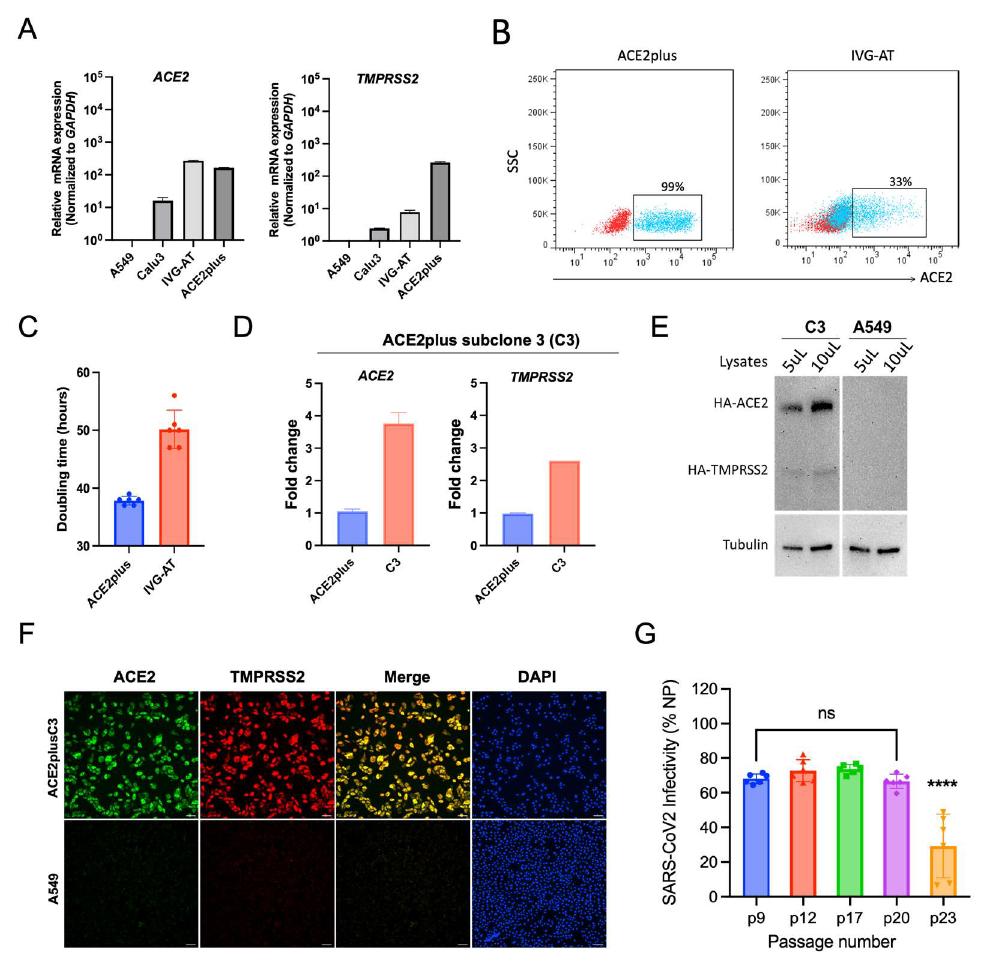
Figure 3. The characterization of the ACE2plus and ACE2plusC3 cell lines. The mRNA expression levels of ACE2 and TMPRSS2 in the indicated cell lines were measured with RT-qPCR ( A , D ). IVG-A and IVG-A/T commercial cell lines were used as comparators. ( B ) The cell surface ACE2 expression level was measured with flow cytometry using live cells. ( C ) The cell-doubling time was determined using a cell growth curve and Celigo Image software. ( E ) The protein expression levels of ACE2 and TMPRSS2 in cells were examined by immunoblotting and immunofluorescence staining ( F ). Scale bar, 100 µm. ( G ) The virus infectivity remains stable between early and late passages (p9, p12, p17, p20, and p23). ACE2plusC3 cells were infected with WT SARS-CoV-2 at an MOI of 0.1 for 48 h. Data are expressed as mean ± SD. n = 6 biological replicates. ns, not significant; ****, p < 0.0001.